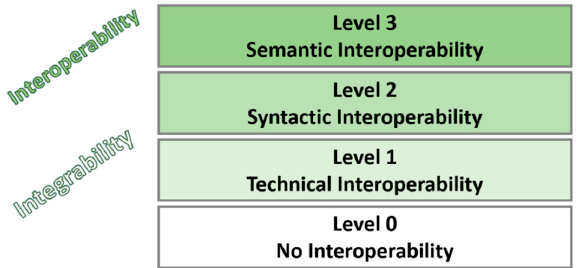
Figure 1. Lower levels of Conceptual Interoperability Model (from [7]).